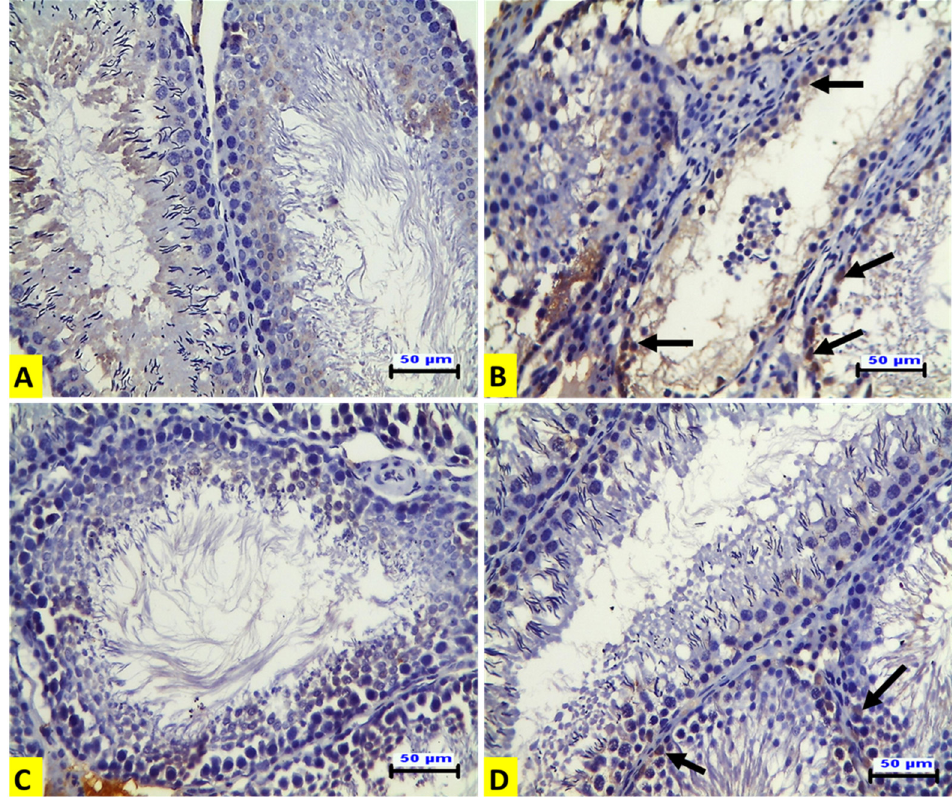
Figure 2. Representative histopathological photomicrographs of transverse sections from rat testes (IHC for p53 X 20 , scale bar 50 µ m). ( A ) The control group shows a negative immune reaction for p53. ( B ) The ACR-treated group shows positive affinity for p53 in the degenerated spermatogenic cells (arrows). ( C ) The EE-treated group shows no immune expression. ( D ) The EE + ACR group shows mild positive affinity for p53 in some spermatogenic cells (arrows).